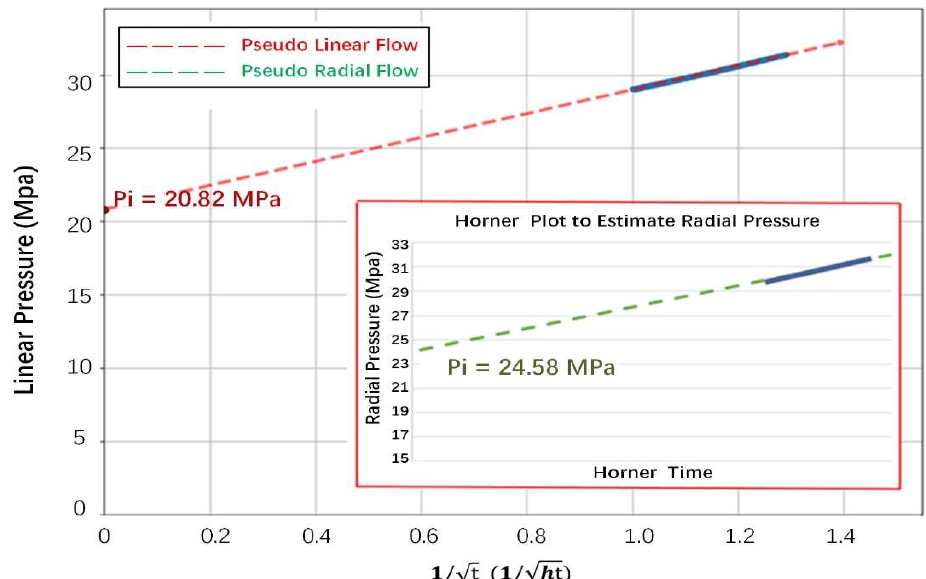
Figure 11. Before Closure (BC) and After Closure (AC) analyses by pressure derivative log–log plot. Signatures of linear and radial flow regimes are slopes of − 0.5 and − 1, respectively, after the fracture closure time.